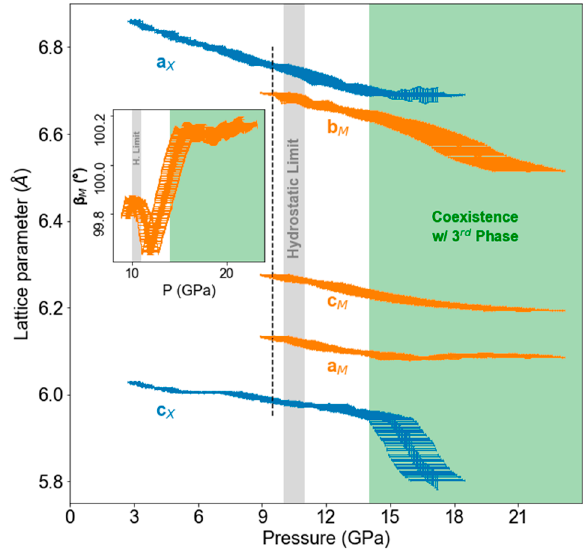
Figure 6. Pressure evolution of all DyPO 4 lattice parameters for the xenotime (a x and c x ) and monazite (a m , b m , c m , and β m ) phases. Error bars represent standard deviation. The vertical dashed line indicates the xenotime → monazite P onset . Green, shaded areas represent the pressure range in which a third (post-monazite) phase of DyPO 4 exists. The thin gray shaded area represents the hydrostatic limit of the pressure medium. The inset shows the monazite beta angle.